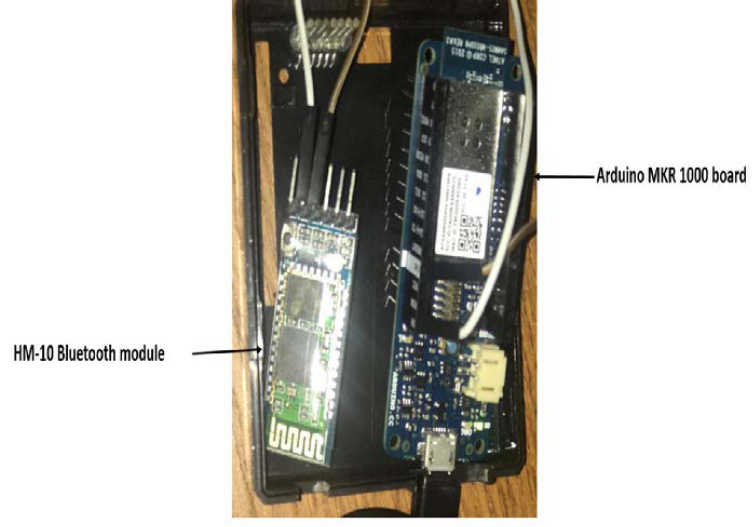
Figure 3. IOT wireless scanner. Figure 3. IoT wireless